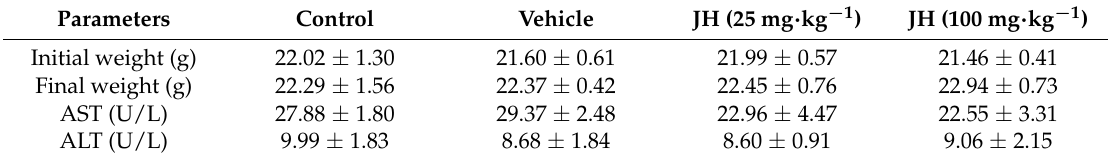
Table 1. Effects of JH on body weight and serum levels of ALT and AST in Ti particle-induced